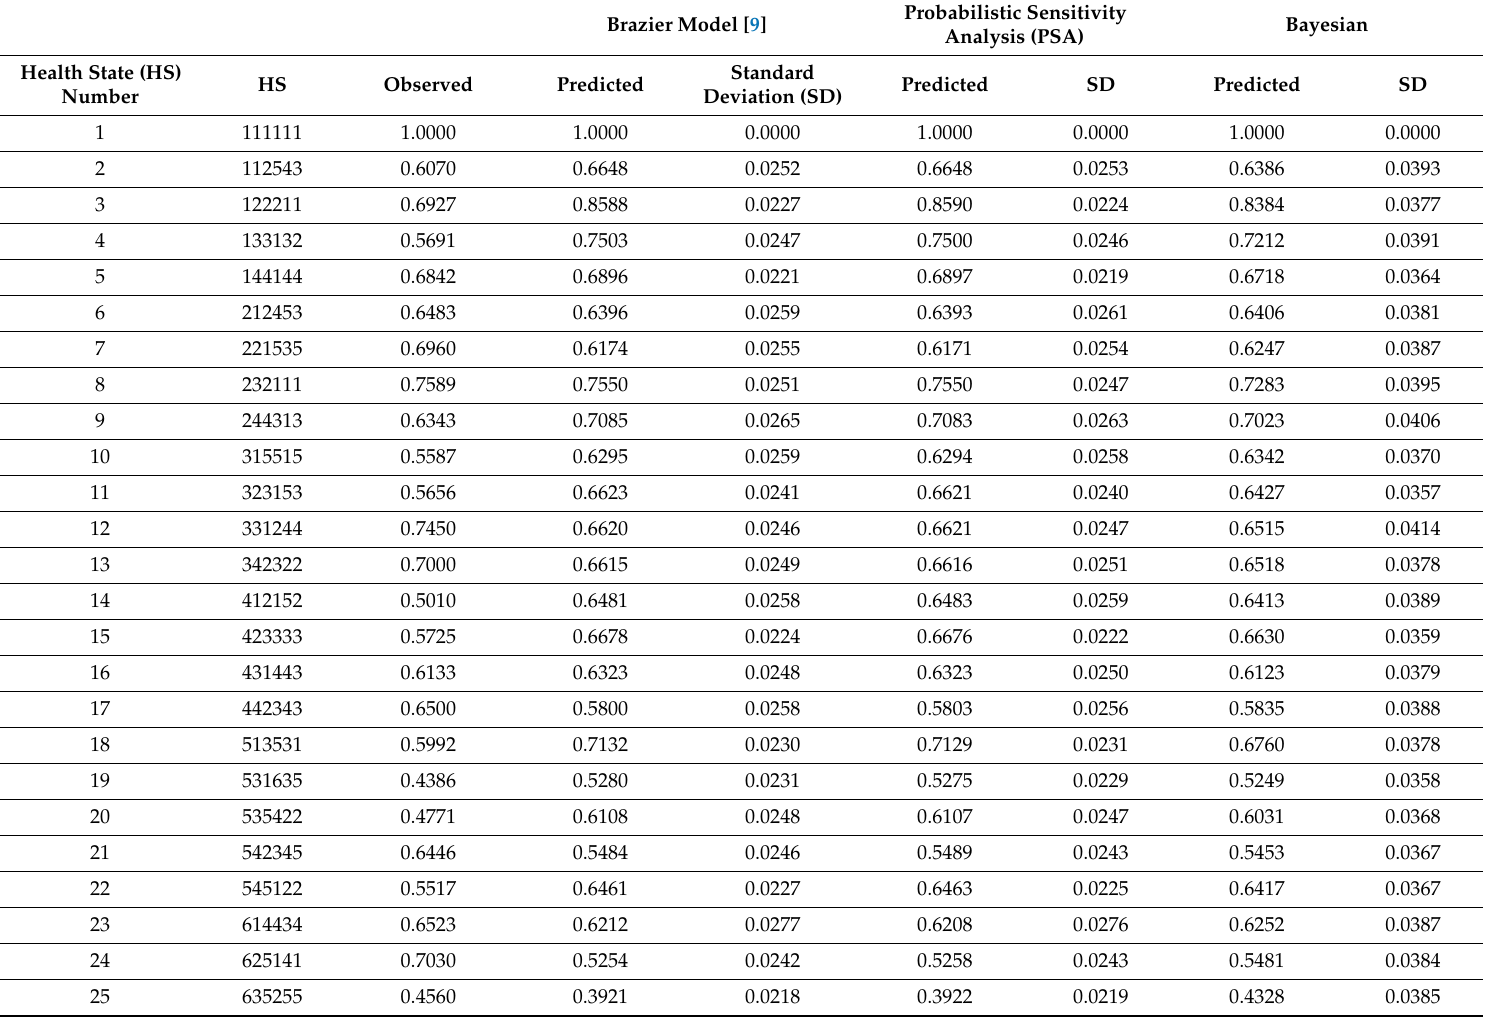
Table 1. Inference for a selection of health